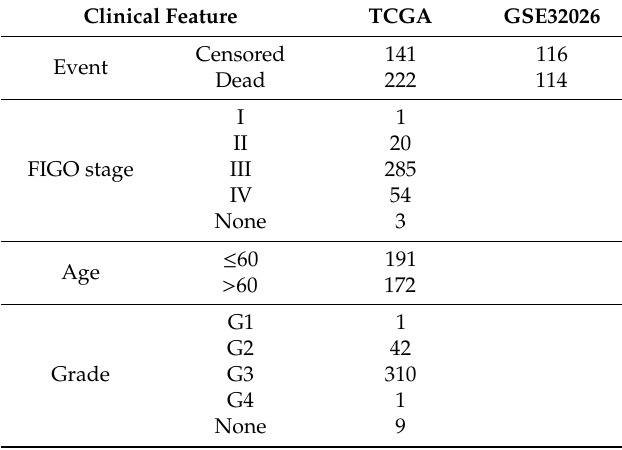
Table 5. Clinical features of the remaining TCGA and GEO Series 32026 (GSE32026)